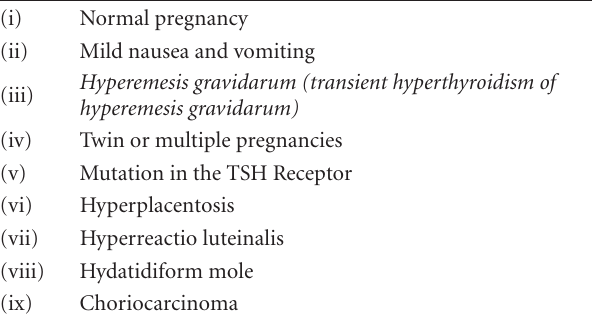
Table 1: Transient nonautoimmune hyperthyroidism in early preg- nancy.